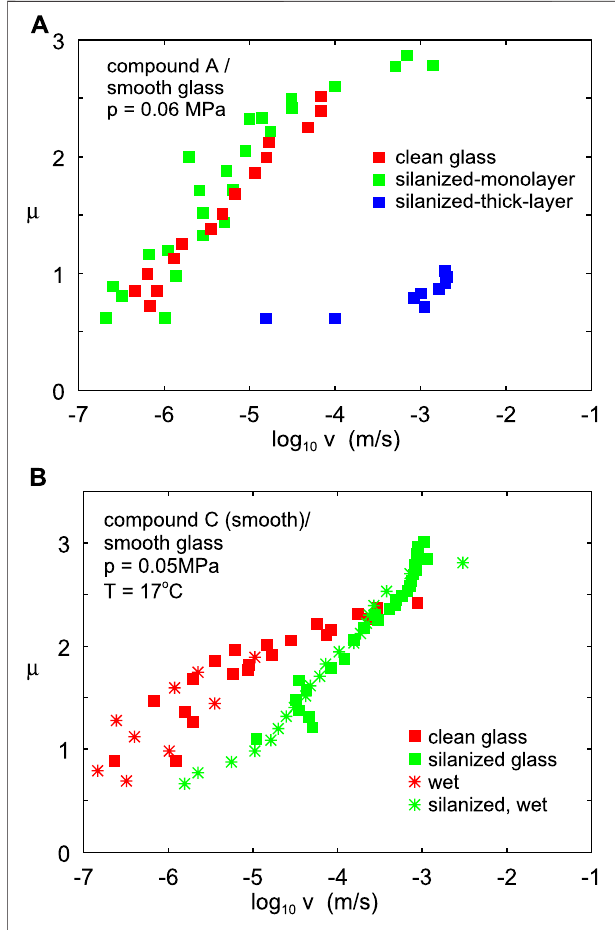
FIGURE 8 | (A) The measured friction coef fi cient for compound A on smooth silica glass plates as a function of the logarithm of the sliding speed. The red symbols are the measured friction coef fi cient on a glass surface ultrasoniccleaned indistilled water.Thegreen symbols wasobtained on the same type of glass plate cleaned in the same way and then covered by an inert monolayer fi lmusing Rain X.The blue symbols isfor a thick fi lm ofRain X. The nominal contact pressure p (cid:1) 0.06 MPa and the temperature T (cid:1) 20 ° C. (B) The measured friction coef fi cient for compound C on smooth silica glass plates as a function of the logarithm of the sliding speed. The rubber surface was cleaned in hot water and then dried just before start of the experiment. The squares are for dry surfaces and the stars in water. The red symbols are the measured friction coef fi cient on a glass surface cleaned by ultrasound in water. The green symbols was obtained on the same type of glass plate cleaned in the same way and then covered by an inert thin fi lm using Rain X. The nominal contact pressure p (cid:1) 0.05 MPa and the temperature T (cid:1) 17 °